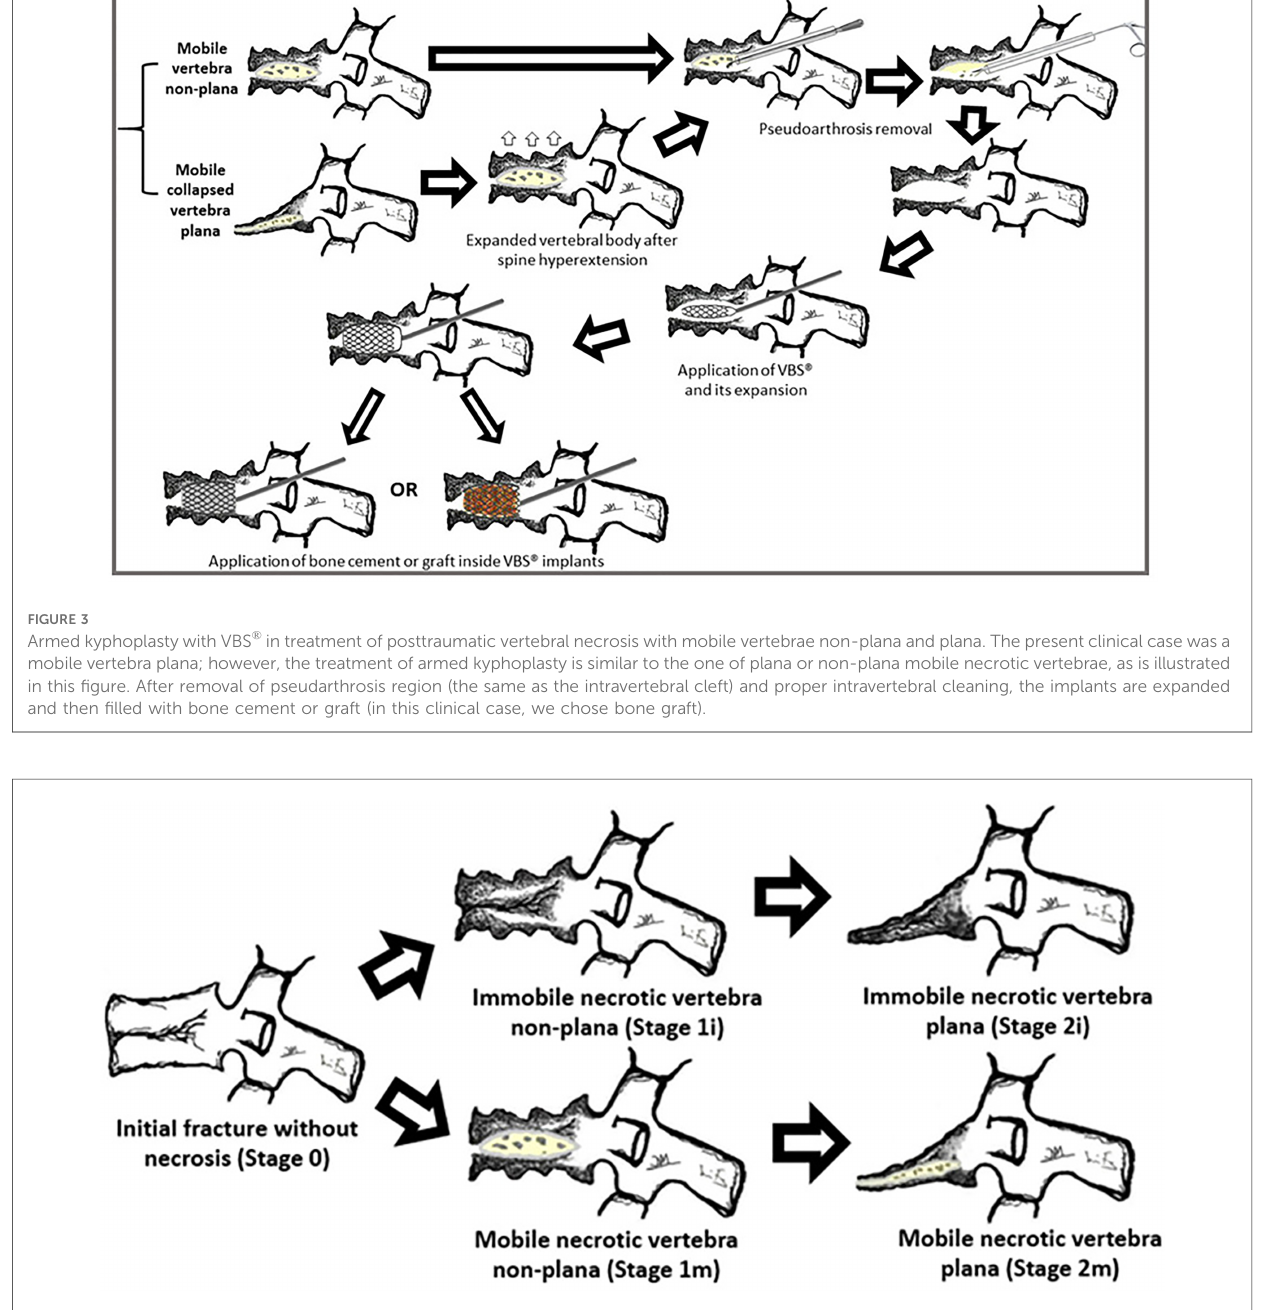
FIGURE 4 Suggested post-traumatic vertebral necrosis evolution stages: stage 0 — initial fracture without necrosis; stage 1i — Immobile necrotic vertebra non-plana; stage 1 m — Mobile necrotic vertebra non-plana; stage 2i — Immobile necrotic vertebra plana; stage 2 m — Mobile necrotic vertebra plana ; highlighting the presence of intravertebral cleft only in the mobile vertebrae marked with m(obile). Immobile vertebrae do not present intravertebral cleft and are marked with (i)mmobile. The drawings on the right side demonstrate vertebral body pseudarthrosis or mobile necrotic vertebra morphology and biomechanics. The determination of vertebral morphology and mobility in the context of post-traumatic necrosis must be performed through the combination of radiographs, including dynamic radiographs in hyperextension and orthostatism, CT and magnetic resonance imaging, also allowing to evaluate the amount of the remaining bone tissue.